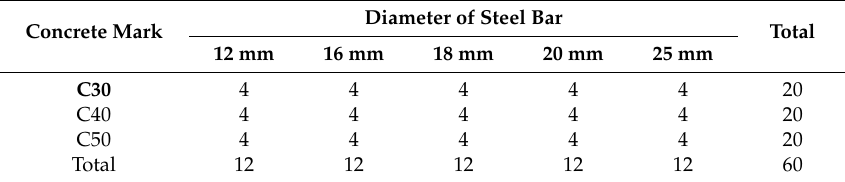
Table 3. SBCC specimens concrete mix ratio.